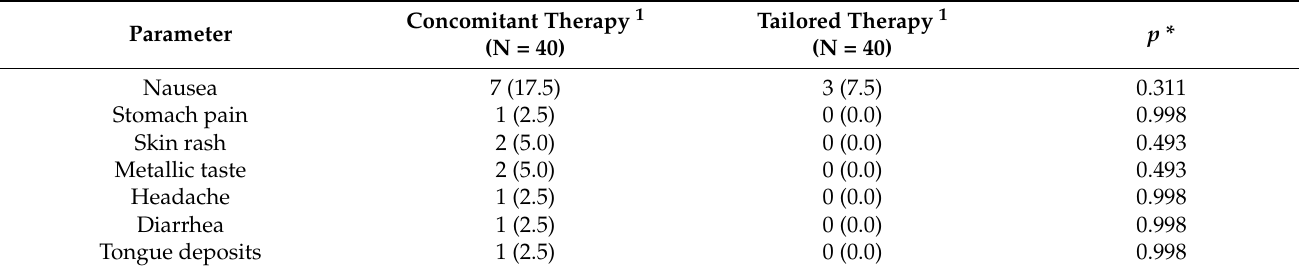
Table 4. The adverse effects of the study population †.